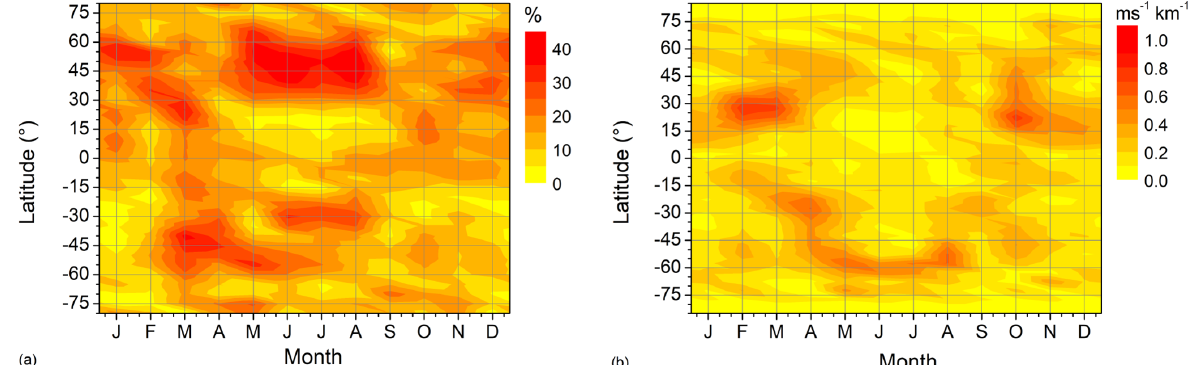
Figure A6. As in Fig. A4, but showing Es relative amplitudes at 112km and zonal wind shear at 112 .